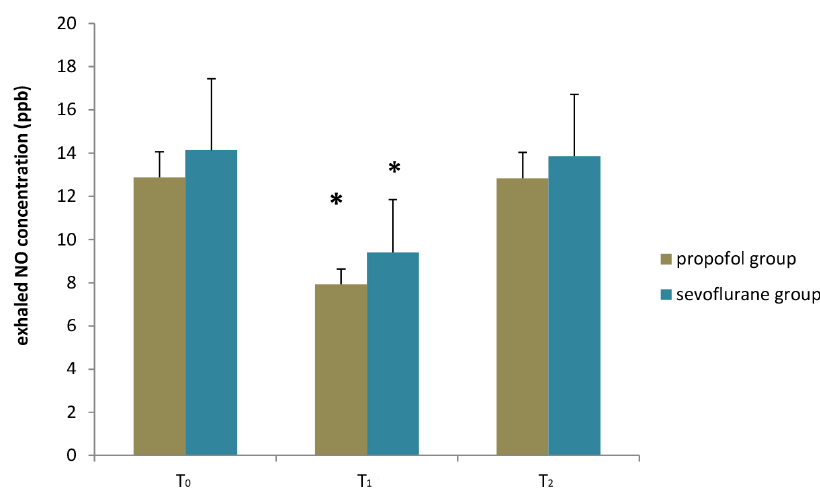
Figure 2. Exhaled NO fluctuation in the propofol and sevoflurane maintenance groups; * p < 0.05 in comparison to baseline (T 0 ).